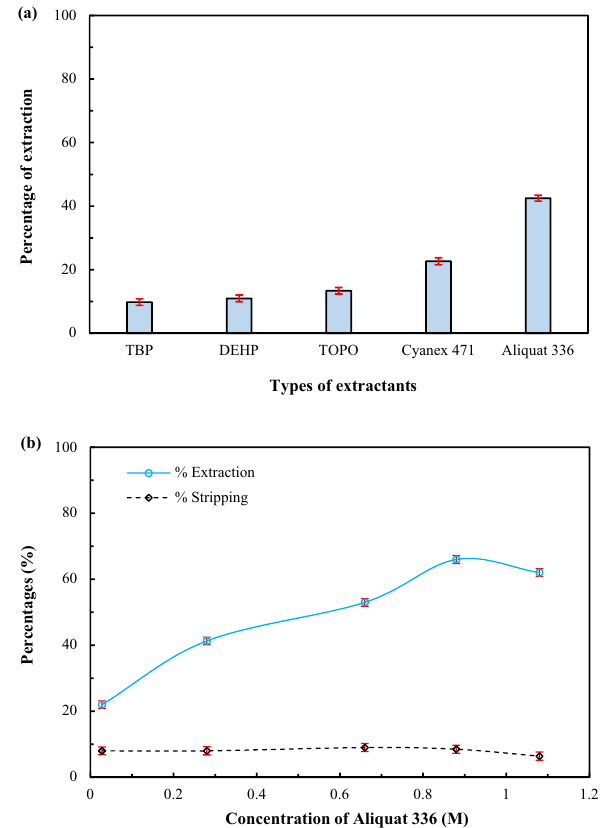
Figure 3. Percentages of extraction and stripping of arsenic ions using pH 6 for feed solution: ( a ) percentages of extraction against types of extractants (0.28 M each) via solvent extraction, stirring 500 rpm for 1 h; standard deviation = ± 1.0. ( b ) percentages of extraction and stripping against concentration of Aliquat 336 via HFSLM using 0.5 M NaOH as the strippant solution, at flow rates of feed and strippant solutions of 100 mL/min; standard deviations for %extraction = ± 1.18 and for %stripping = ±